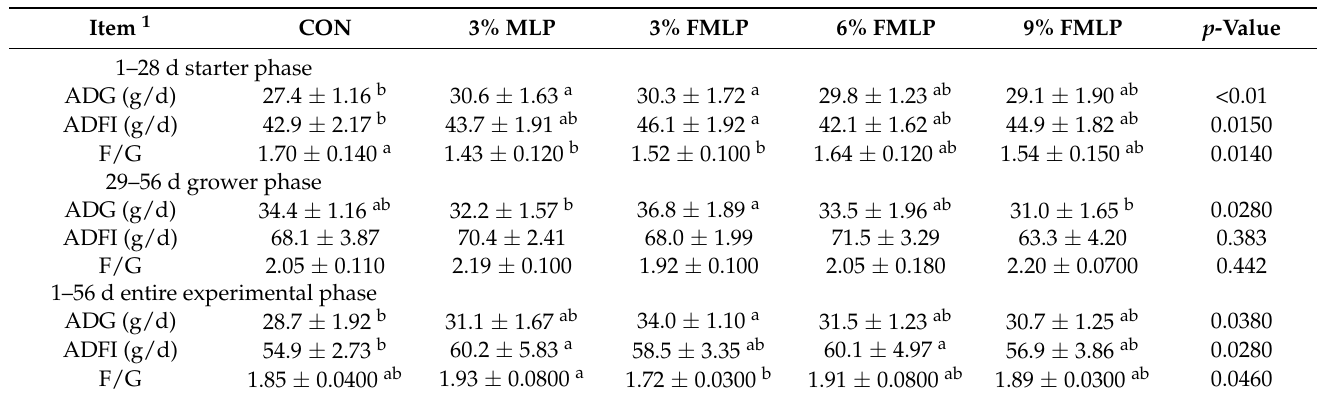
Table 3. Effects of FMLP on growth performance of